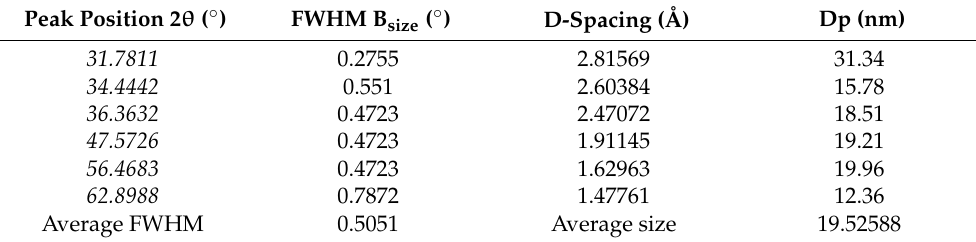
Table 5. ZnO NPs average crystalline size calculation using Debye–Scherrer Equation. Peak Position 2 θ ( ◦